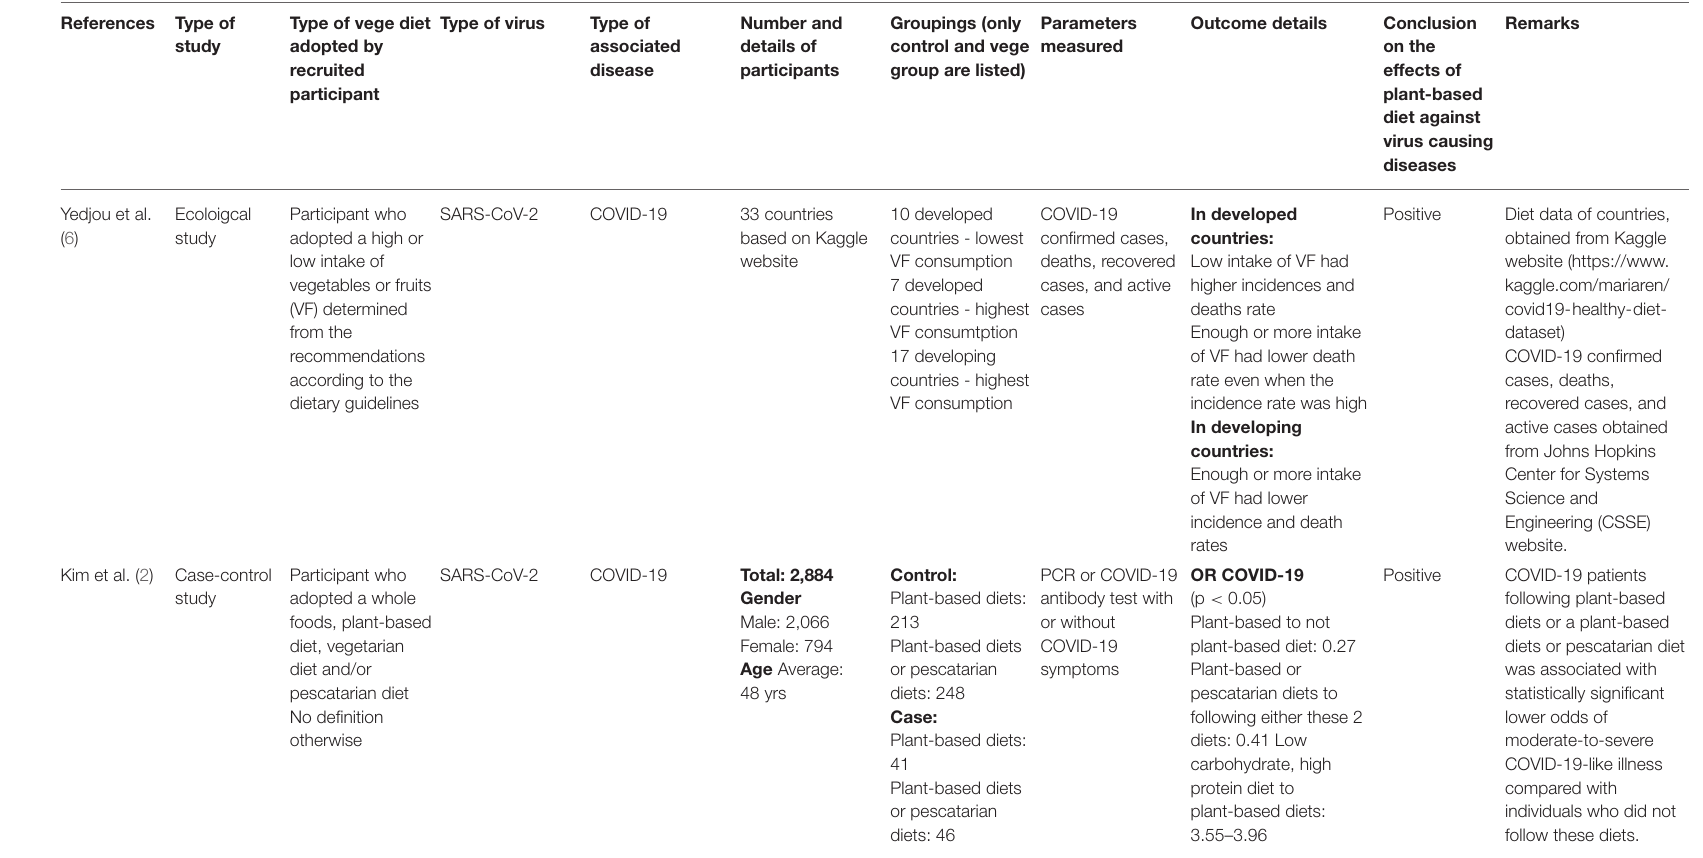
TABLE 1 | Clinical studies on the effects of plant-based diet on virus causing